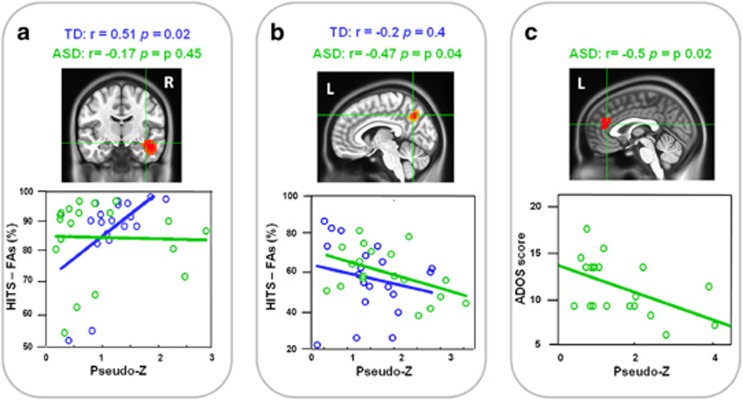
Significant correlation coefficients (all P<0.05) between event-related MEG activity in (a) the right hippocampus (1-back; from 450 to 500 ms) and (b) the left precuneus (2-back; from 325 to 375 ms), and behavioural performance in TD (blue) and ASD (green) children. (c) Significant correlation coefficient (P<0.05) between event-related MEG activity in ACC (1-back; from 450 to 500 ms) and ASD symptom severity in ASD. ACC, anterior cingulate cortex; ASD, autism spectrum disorder; FA, false alarm; MEG, magnetoencephalography; TD, typically developing children.